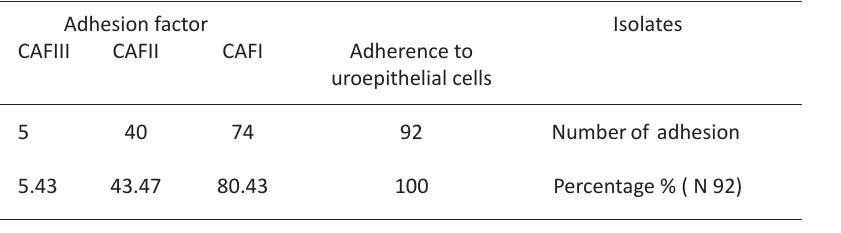
Table 2. The adhesion factor and Percentage of colony adhesion factors pattern of E. coli clinical